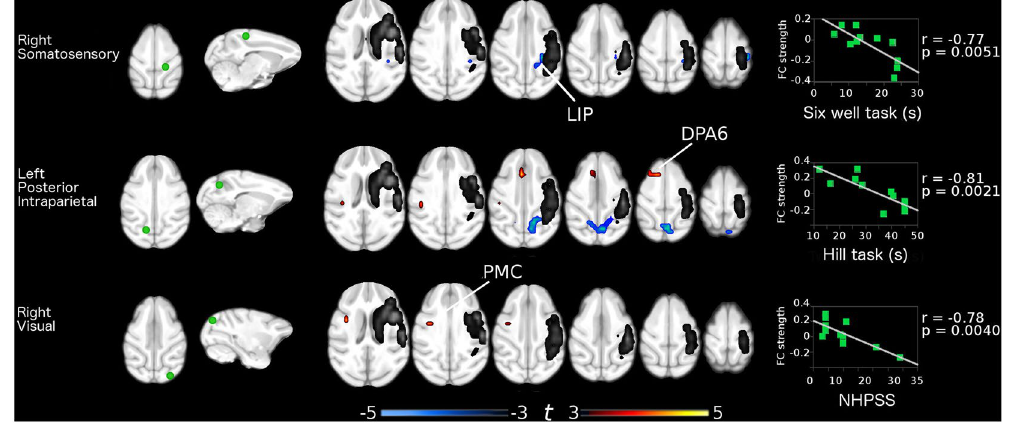
Figure 3. Functional connections showing significant correlation with behavioral scores. Left column shows the seeds location. Middle column shows the areas that had significant Functional Connectivity (FC) differences between groups that also correlated with the behavioral impairment as shown in the right column. The stroke area is showed in gray